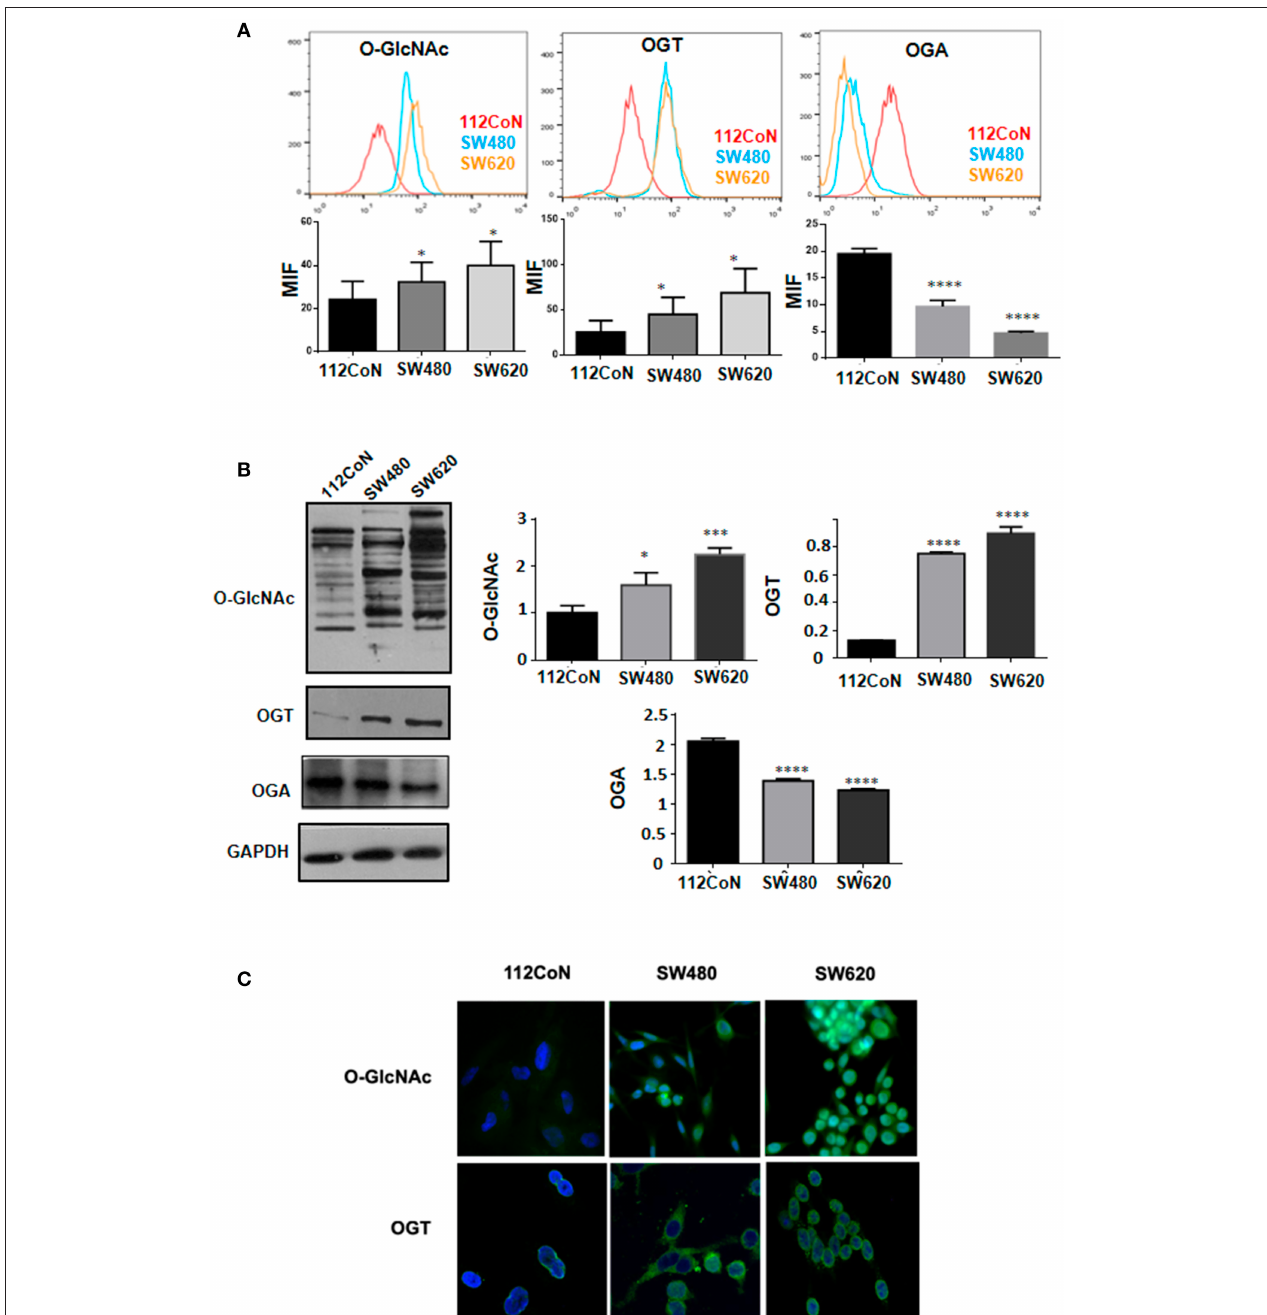
FIGURE 2 | O-GlcNAcylation levels and OGT expression are higher in colon cancer cell lines compared with normal colon cell line while OGA expression diminished in colon malignant cells compared with non-malignant ones. (A) Flow cytometry. The data represent the means ± SEM from at least three independent assays * p = 0.01; *** p = 0.001; **** p = 0.0001 compared with control 112CoN cells. (B) Western blot and (C) Immunofluoresce assay showing the different levels of O-GlcNAcylation and OGT expression in each cell line. Normal cells: 112CoN, cancer cells: SW480 and